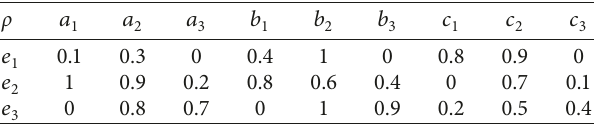
Table 1: Relation between vertices and parameters of perfect fuzzy soft tripartite graphs.